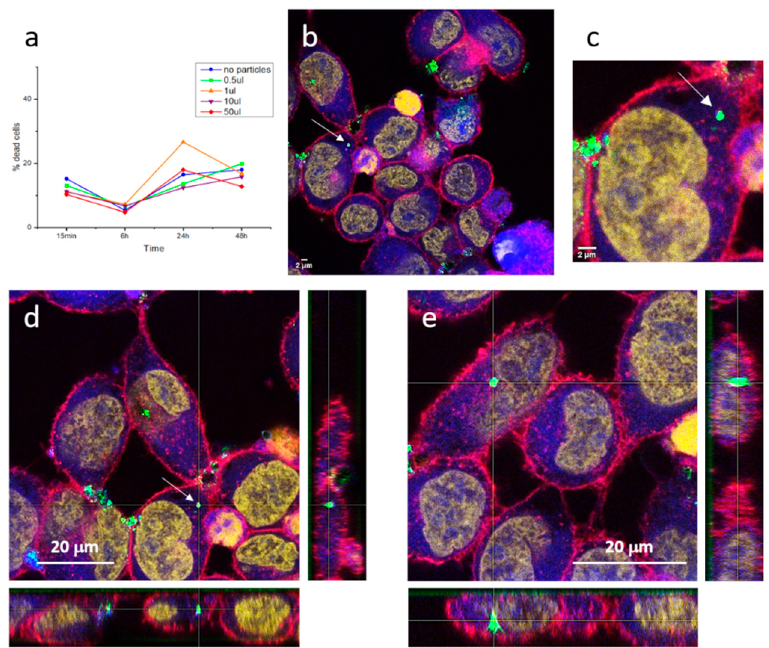
Figure 8. ( a ) Flow cytometry analysis of cell cytotoxicity after 15 min, 6 h, 24 h, and 48 h of exposure of HeLa cells to different concentrations of SrAlO:Eu,Dy@SiO 2 powder 400 °C/30 min. ( b – e ) Confocal images of HeLa cells incubated with the SrAlO:Eu,Dy@SiO 2 composites at 100 μ g/mL for 30 min. After PBS washes, cells were stained with 0.2 μ M calcein for 30 min at 37 °C + 5 μ g/mL WGA for 5 min at RT+ 1 μ M TO-PRO for 30 min at RT. Measurements were performed with Laser line 488 nm/HyD 497–555 nm (ex/em), Laser line 550 nm/HyD 559–630 nm (ex/em), Laser line 633nm/HyD 648–736 nm (ex/em), and Laser line 561nm/PMT 550–573 nm (ex/detection reflection). The following reference colors are used: green: SrAlO:Eu,Dy@SiO 2 composites; red: membrane; blue: cytoplasm; yellow: cellular nucleus. White arrow indicates a composite (or small cluster of composites) inside the HeLa cell.